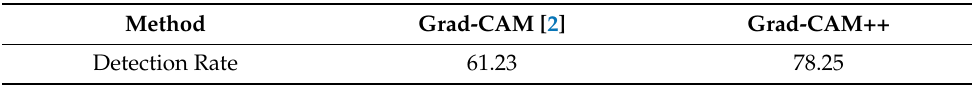
Table 1. Detection rate comparison.